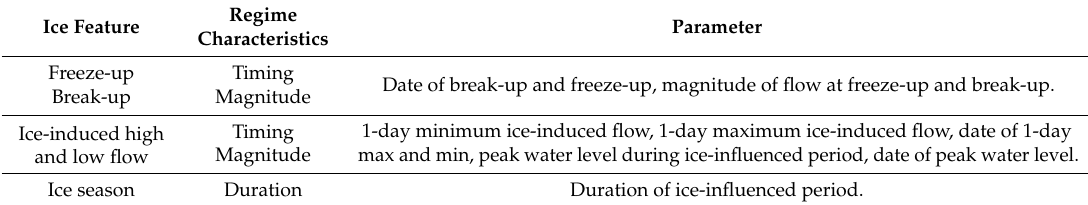
Table 2. Ice influenced indices in Cold-regions Hydrological Indicators of Change (CHIC), after